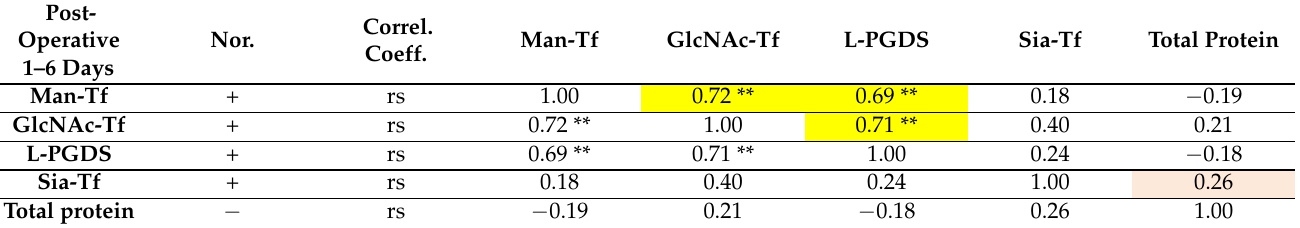
Table 10. Correlation coefficients and data normality of markers at post-operative days